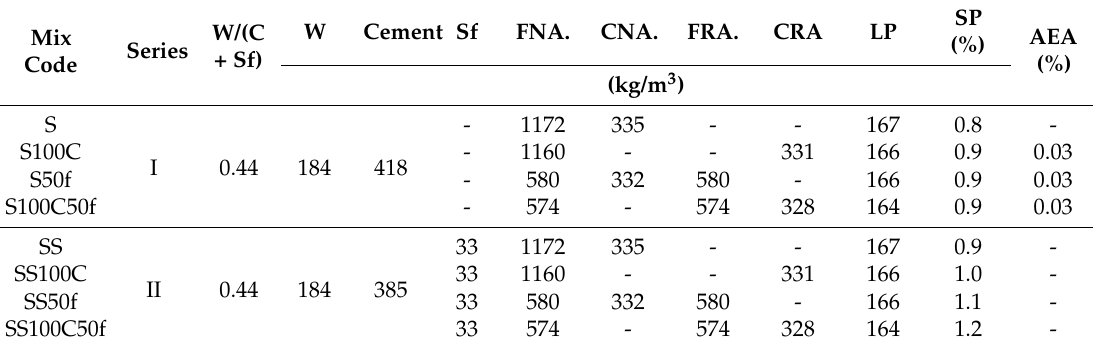
Table 2. Mix proportions of the